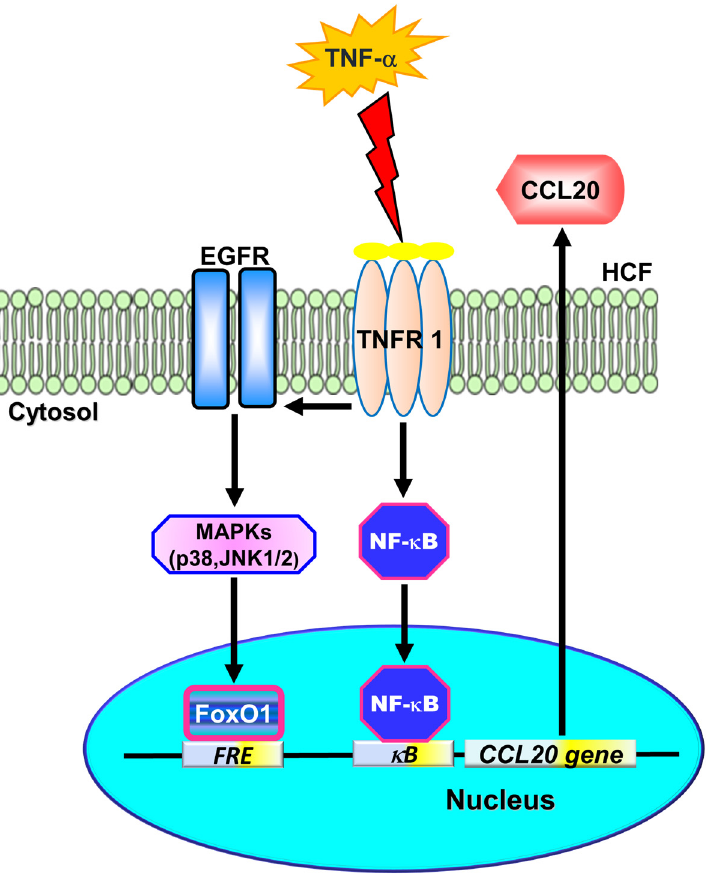
Figure 8. Schematic diagram illustrating the proposed signaling pathway involved in TNF- α -induced CCL20 expression and secretion in HCFs. TNF- α -induced CCL20 expression was, at least partially, mediated through binding to TNFR1 leading to transactivation of EGFR. Activated EGFR promoted the phosphorylation of p38 MAPK- or JNK1/2-dependent FoxO1 activation, which further bound with the FoxO1 response element (FRE) on the CCL20 promoter. In addition, TNF- α also turned on NF- κ B transcription factors. Either FoxO1 or NF- κ B activation could enhance the expression of CCL20 induced by TNF- α , which may be engaged in the inflammatory responses in HCFs. A better understanding of mechanisms underlying the regulation of the CCL20 gene by TNF- α will support more opportunities to develop anti-inflammatory therapeutic strategies for treating cardiac inflammation.